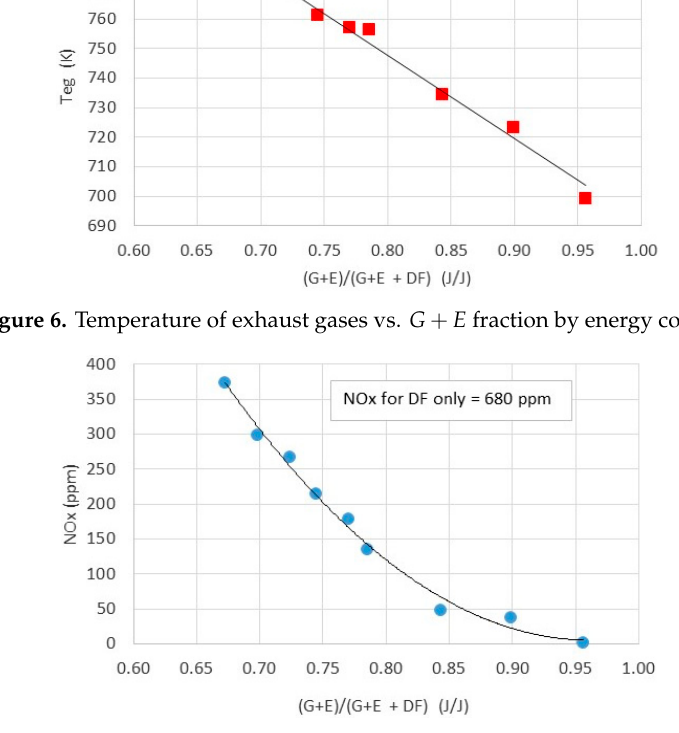
Figure 7. NOx vs. 𝐺 + 𝐸 fraction by energy content. Figure 7. NOx vs. G + E fraction by energy